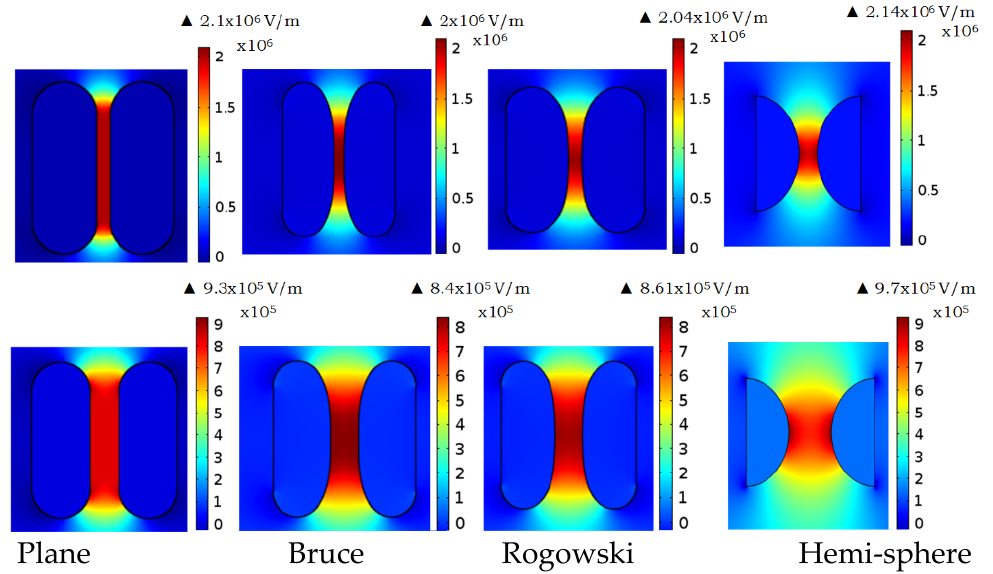
Figure 7. E distribution for electrode profiles for the case d/t < 0.5 (upper) and d/t > 0.5 (bottom).